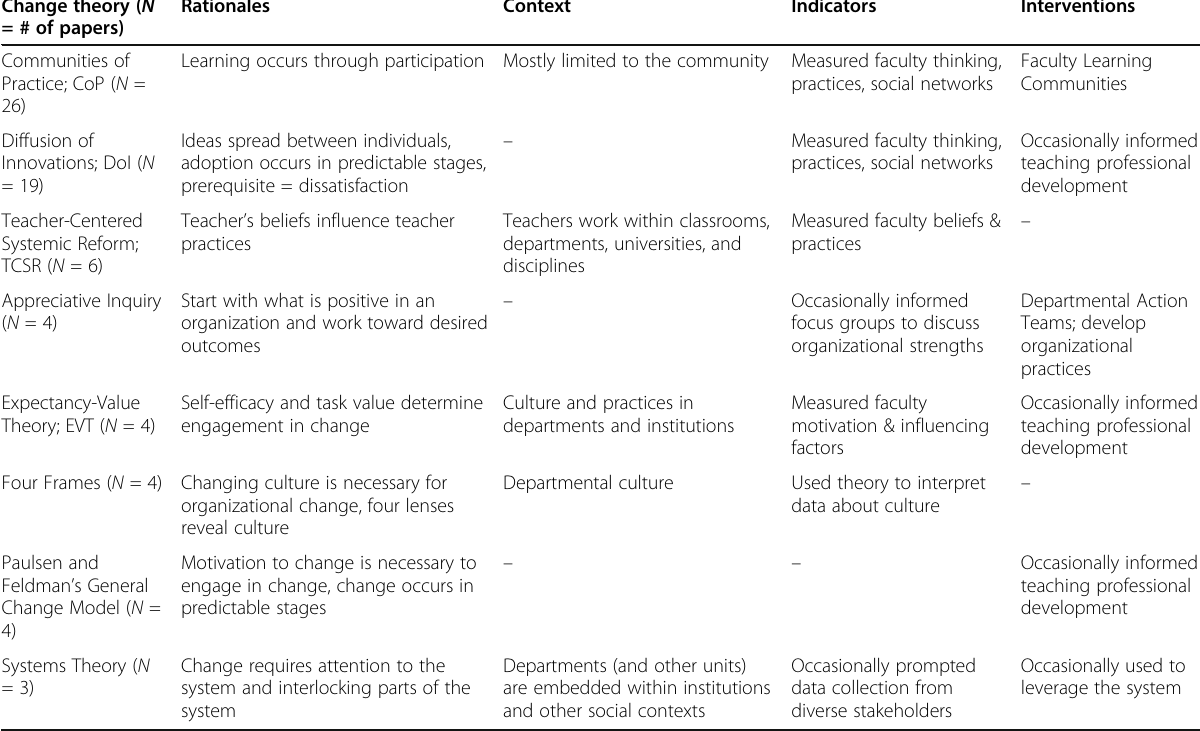
Table 3 Brief overview of how the eight most commonly used change theories informed project rationales, context, indicators, and interventions in the 97 reviewed papers. This mark ( – ) indicates that this was rarely or never informed by the theory within our